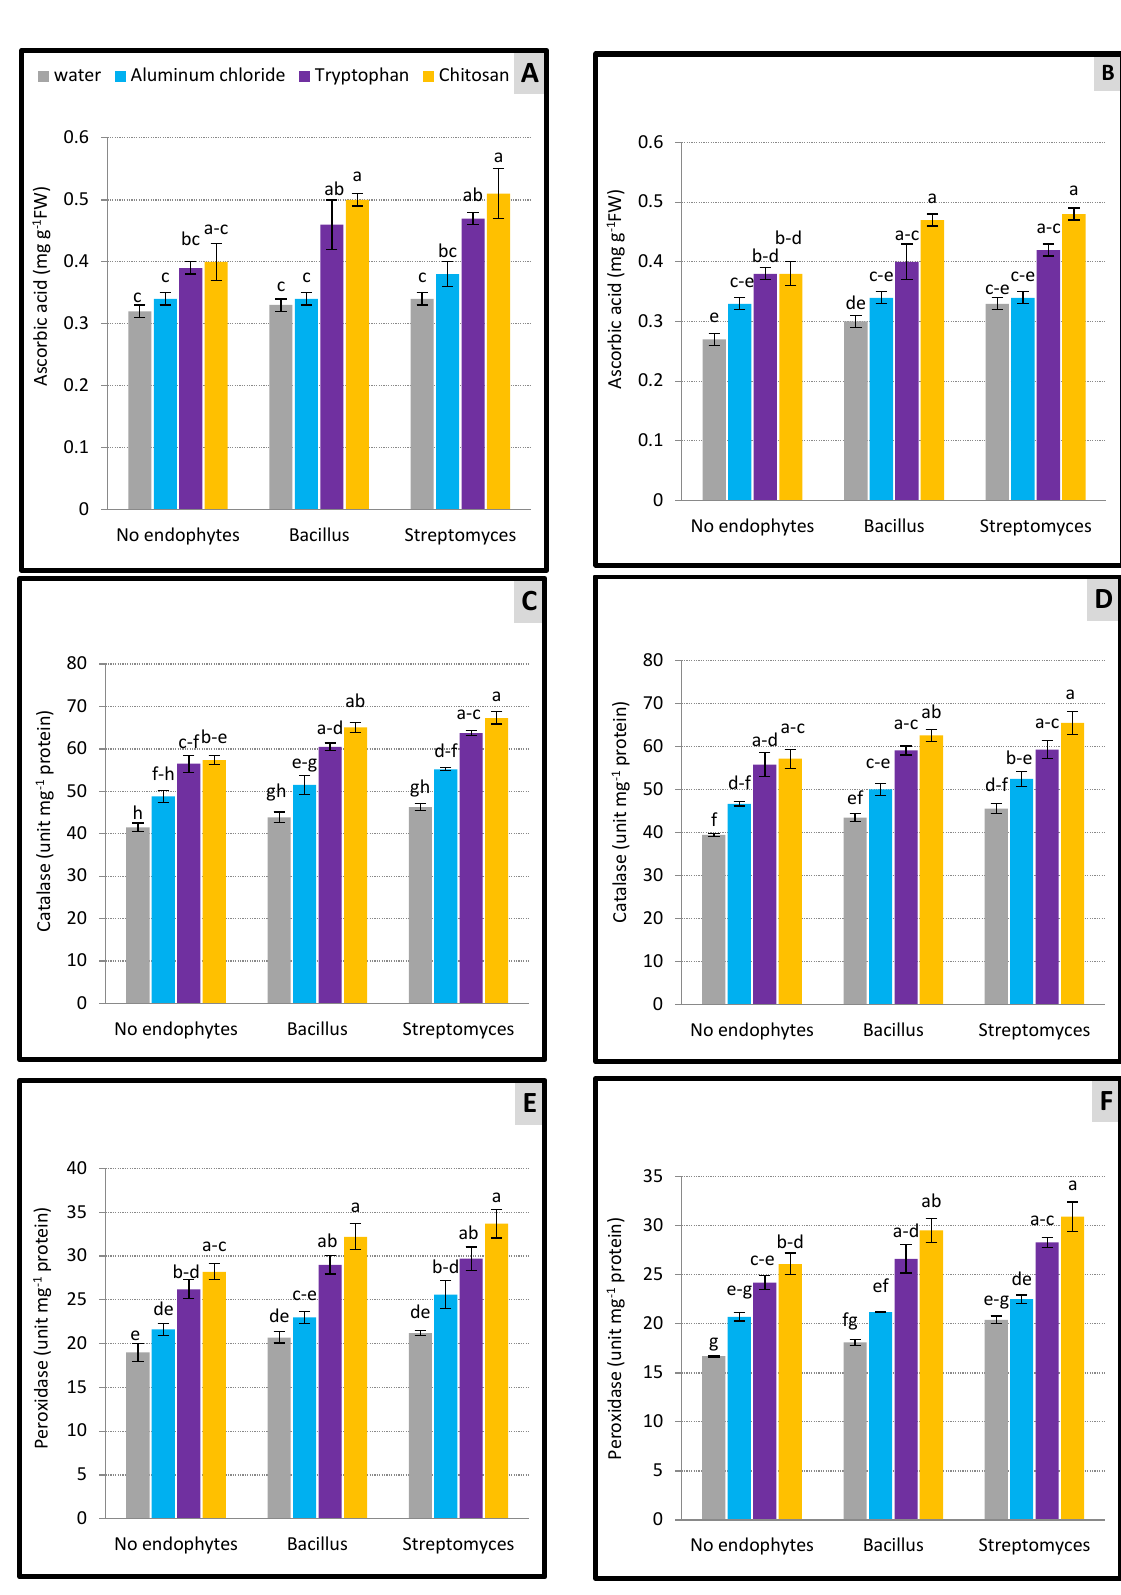
Figure 5. Interactive effect of endophytic microorganisms and abiotic elicitors on ( A , B ) ascorbic acid (mg g −1 FW), and activity (unit mg −1 protein) of ( C , D ) catalase and ( E , F ) peroxidase enzymes in periwinkle plant shoot in both seasons (FW, fresh weight). Columns with the same letter in each chart are non-significantly ( p ≤ 0.05) different according to Tukey’s test. Means of five replicates are presented with ±SE.